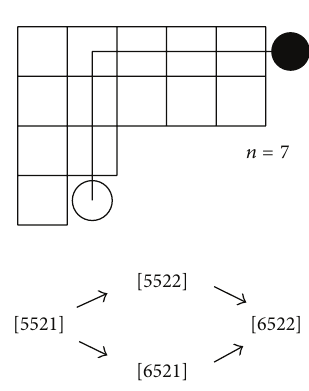
Figure 4: Example of singlets.